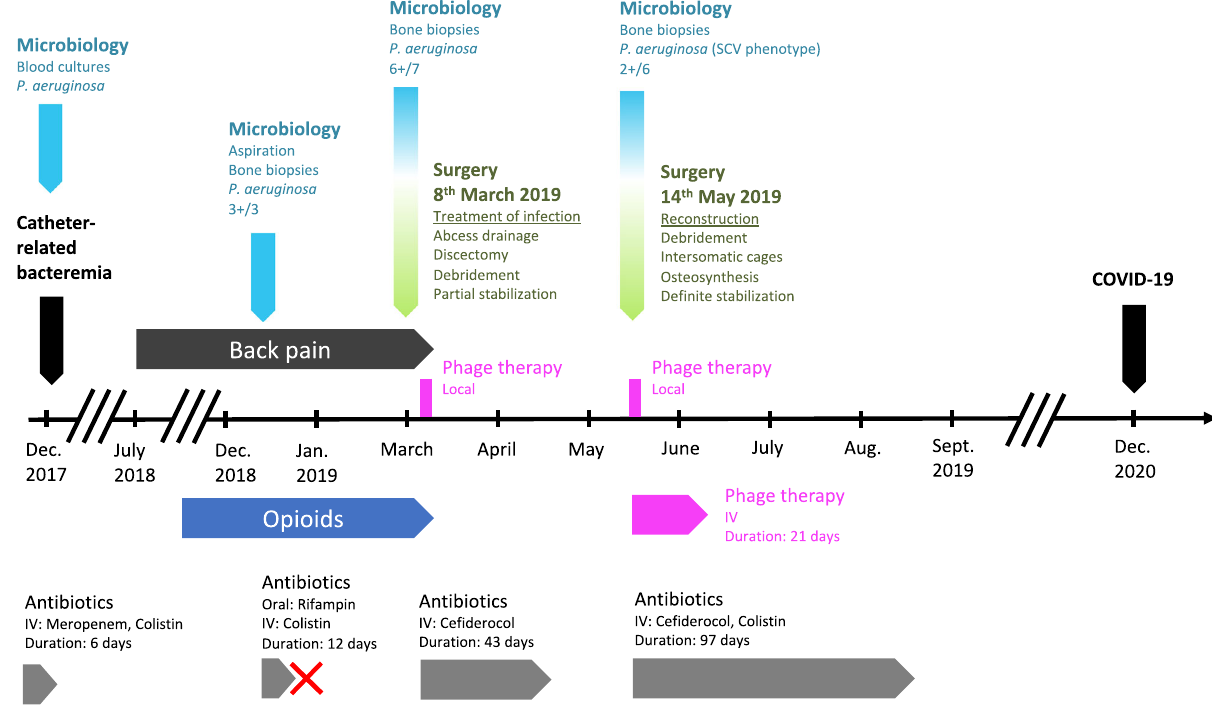
Fig. 1 Timeline of the most relevant surgical procedures (green), microbiological results (light blue), opioid therapy (dark blue), antibiotic therapies (dark gray), and phage therapy (magenta). Clinical events are indicated in black. The red cross indicated withdrawal of antibiotics due to the occurrence of a serious adverse event (mild kidney